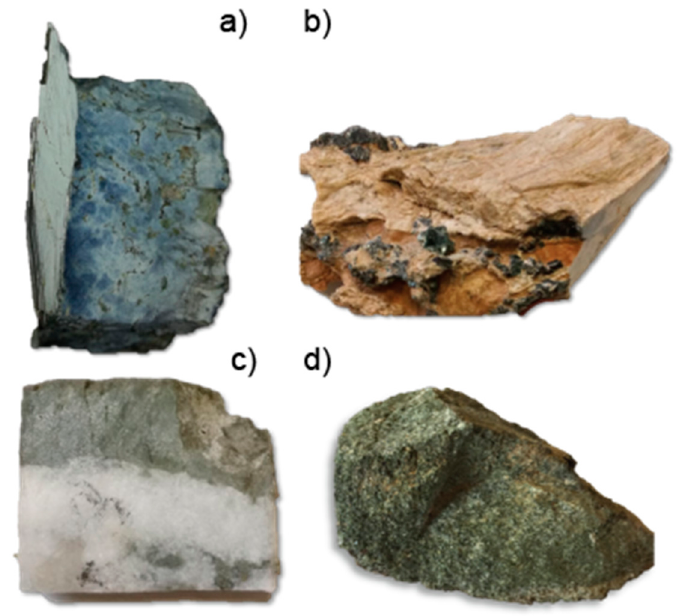
Figure 1. Close up photographs of the analyzed samples: ( a ) serpentinized peridotite; ( b ) serpentinite with a tremolite vein; ( c ) metabasalt with a plagiogranite vein; ( d ) pyroxenite cut by a talc and tremolite-filled vein.